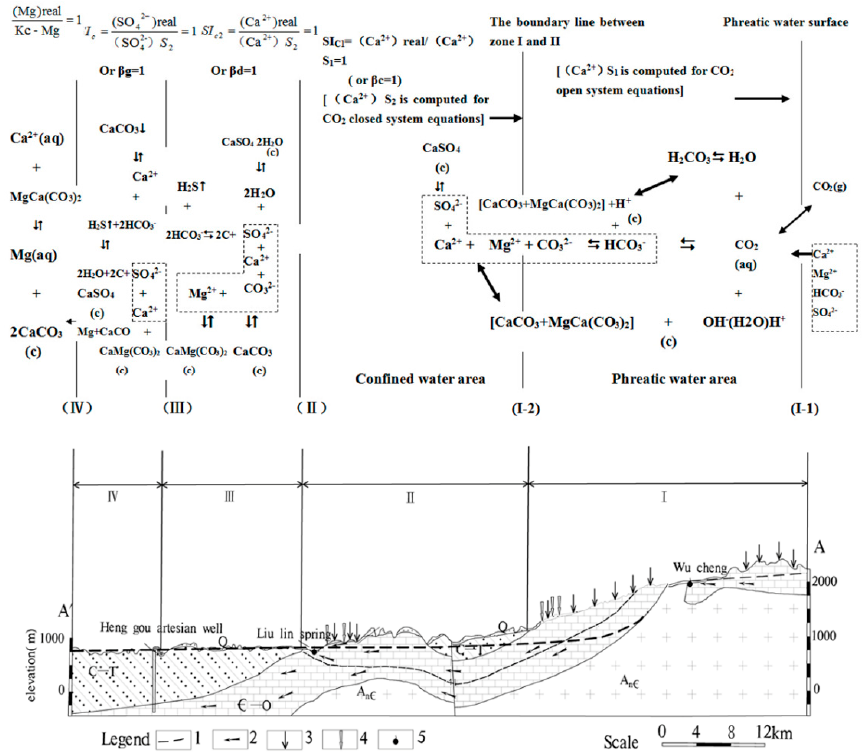
Figure 2. The model diagram of hydrogeology-hydrogeochemical of Liulin spring area. 1. Karst groundwater table; 2. flow directions of groundwater; 3. recharge of precipitation; 4. recharge of surface water; 5. spring.